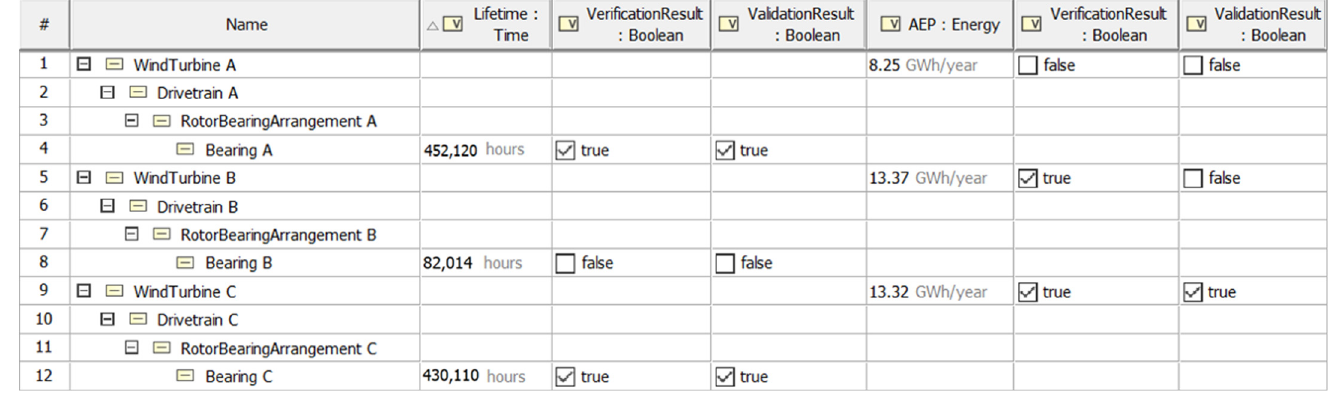
Figure 12. The verification & validation results of the WT system under different design alternatives.